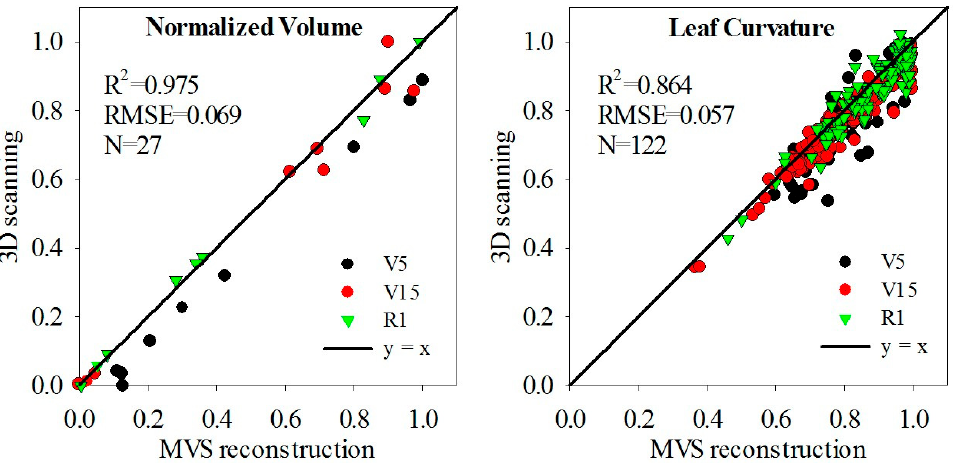
Figure 8. Normalized volume and leaf curvature comparison derived by 3D scanning and MVS reconstruction point clouds.